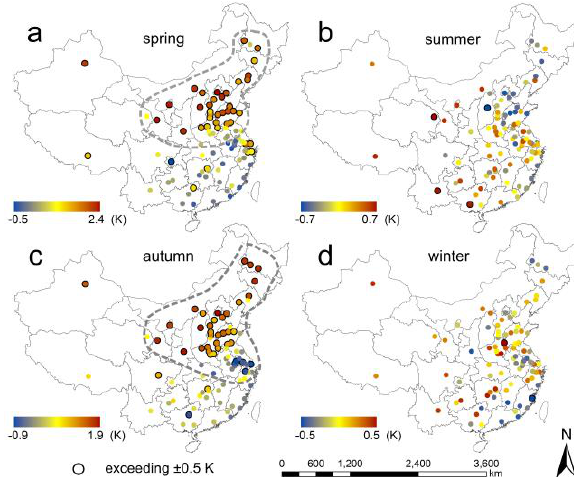
Figure 4. Spatial pattern of ∆SUHII (K) during the night for the four seasons. Regions where most cities have a significant ∆SUHII are highlighted with grey dotted curve box.